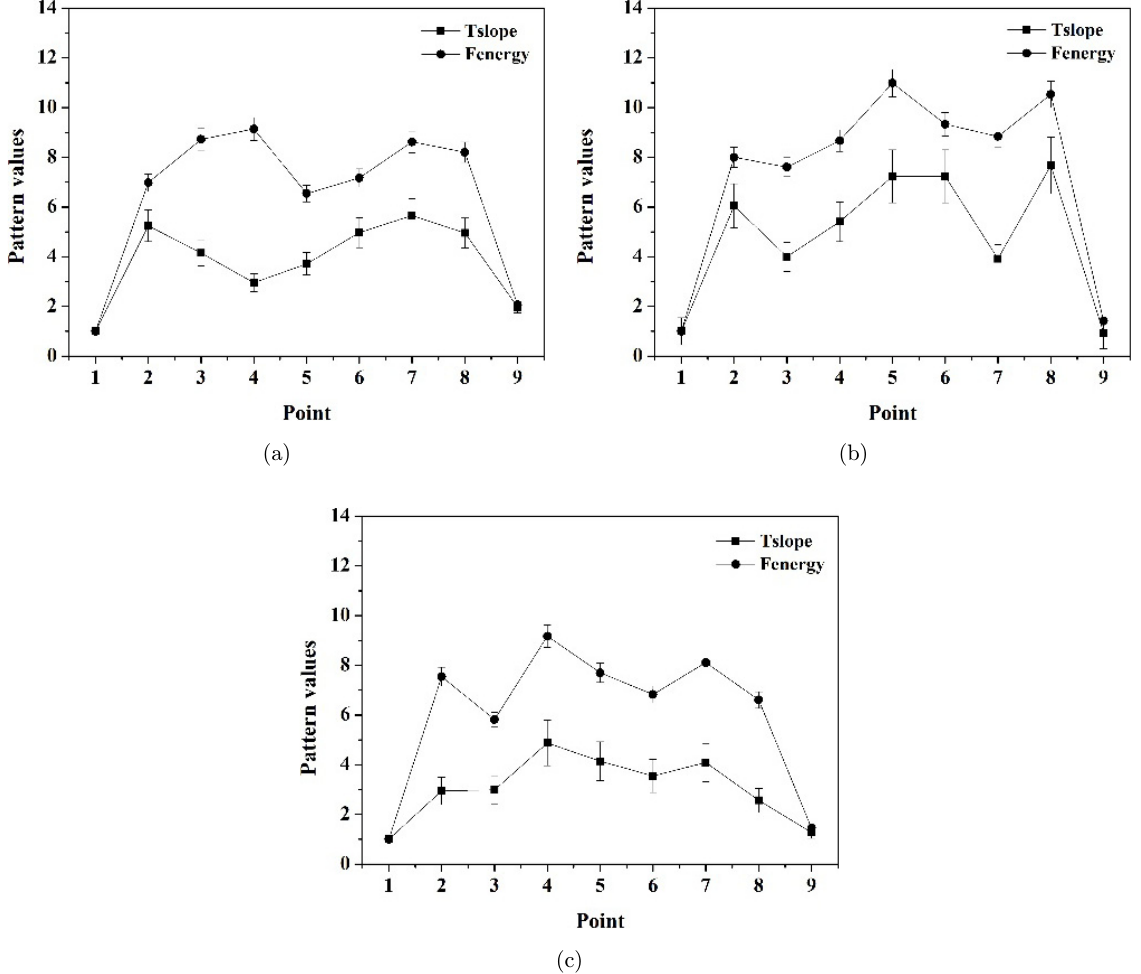
Fig. 6. The pattern values of nine sample points from di®erent animal vertebra models. (a) porcine vertebra models, (b) bovine vertebra models, (c) ovine vertebra